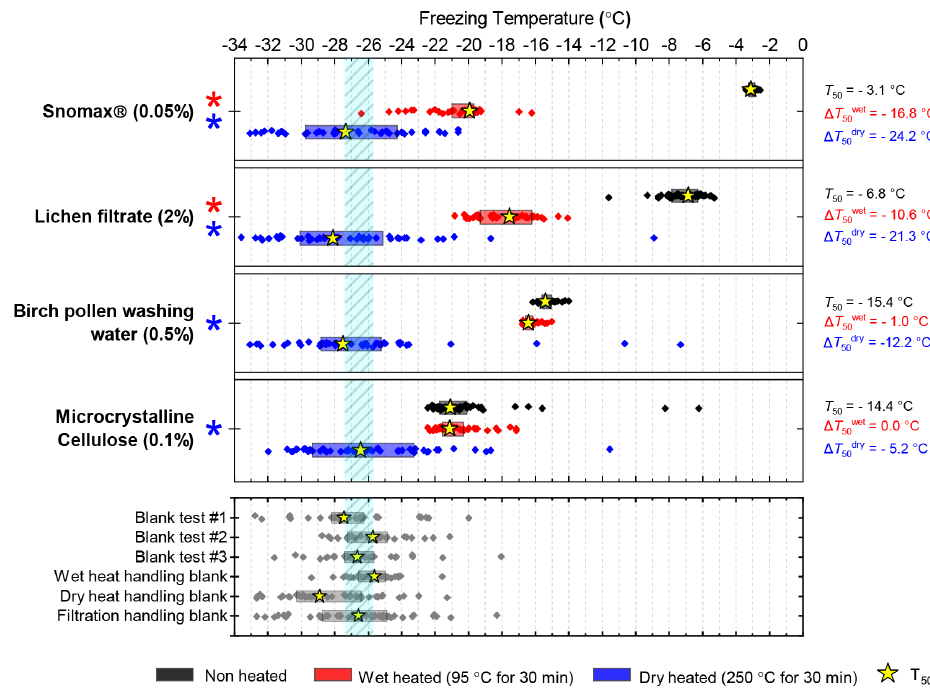
Figure 7. Boxplot showing freezing temperatures before (black) and after heat treatments (red for wet heat, blue for dry heat) for biological INP samples along with handling blank data for the filtration procedure described in Sect. 2.2. Table 4. Summary of the characteristic responses of classes of INPs to wet and dry heat